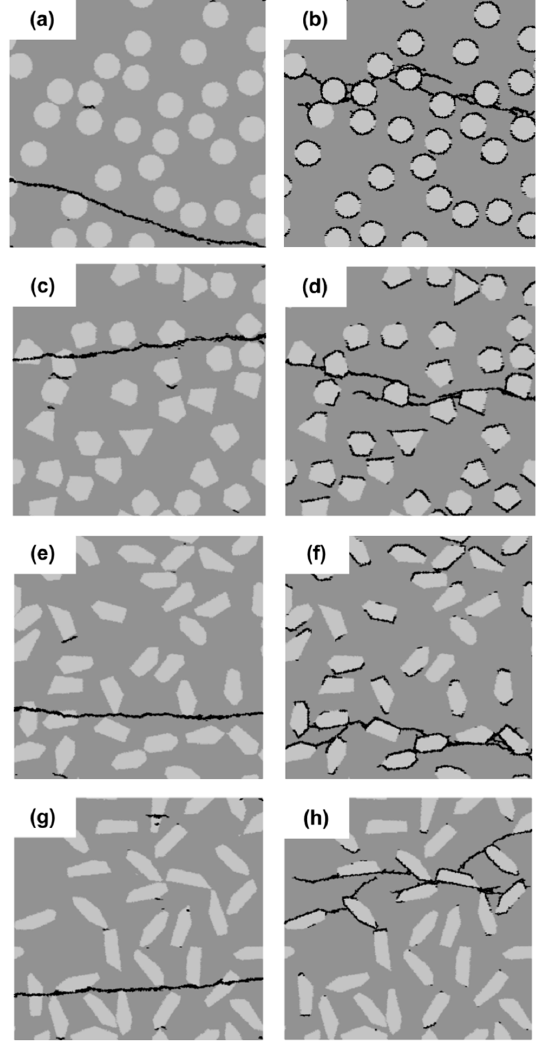
Figure 9. Micro-crack patterns of specimens with strong interface (left) and a weak interface (right) for four different shapes of filler particles (Shape 1 ( a , b ), Shape 2 ( c , d ), Shape 3 ( e , f ) and Shape 4 ( g , h )).